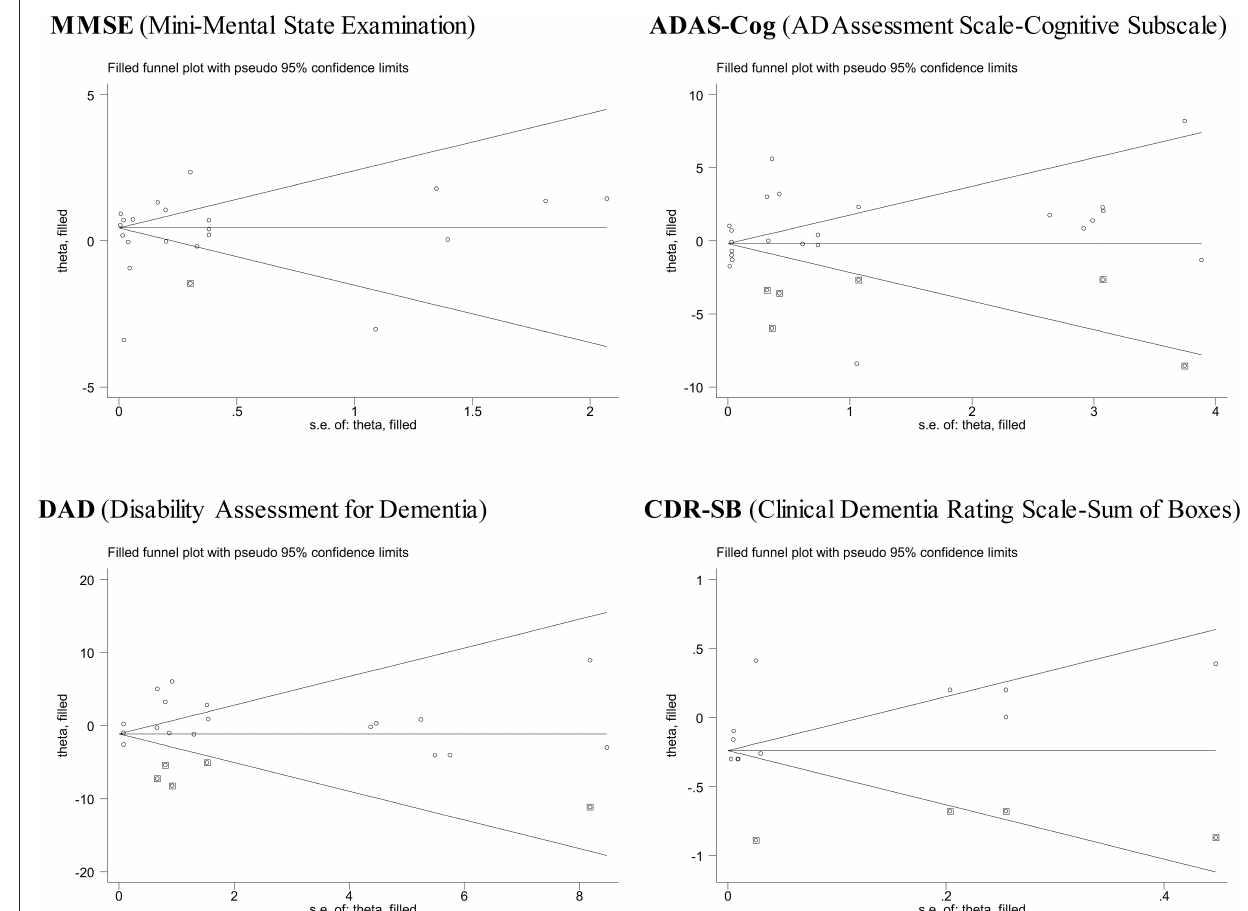
associated with a significant increase in MMSE (SMD: 0.588; 95% CI: 0.226–0.95) and DAD (SMD: 0.919; 95% CI: 0.105–1.943),